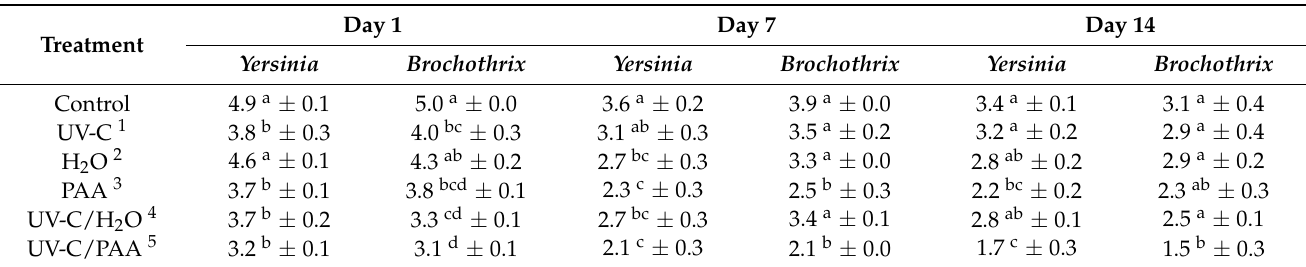
Table 9. Sensory results (LSM ± SE) of pork after UV-C, peracetic acid (PAA), and H 2 O treatments alone and in combination of with Yersinia enterocolitica or Brochothrix thermosphacta inoculated pork samples after 1, 7, and 14 days of storage ( n = 3).